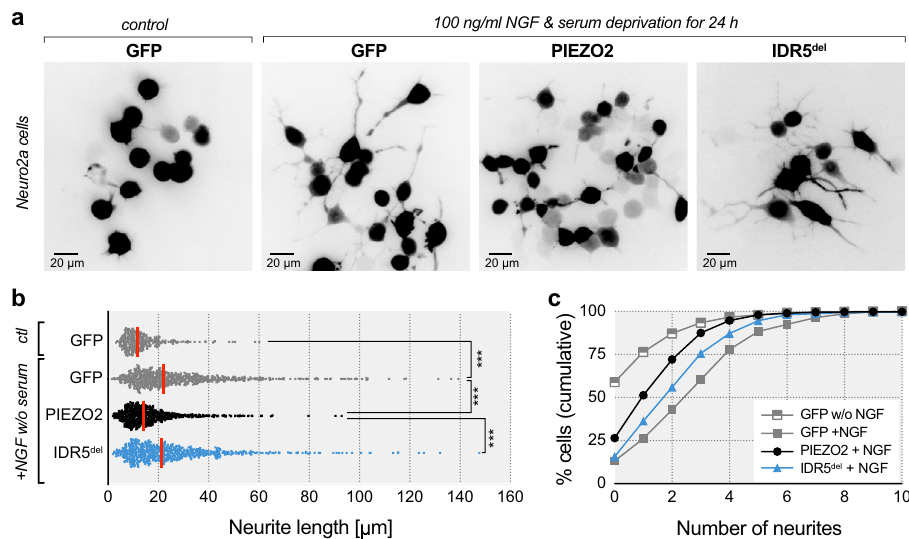
Fig. 6 PIEZO2 but not IDR5 del inhibits neurite outgrowth from N2a cells. a Representative inverted fl uorescent images of N2A-P1KO transfected with GFP vector in control medium (left), GFP, PIEZO2 (middle) or IDR5 del (right) in medium without serum and with nerve growth factor (NGF). b Representation of the longest neurite measured (in µ m) per cell for GFP in control medium and GFP (gray), PIEZO2 (black) and IDR5 del (blue) in medium without serum and with NGF. Comparison with Kruskal – Wallis test, p < 0.0001, and Dunn ’ s post-test: GFP control vs. GFP + NGF w/o serum ( P < 1e − 15), GFP + NGF w/o serum vs. PIEZO2 ( P < 1e − 15), PIEZO2 vs. IDR5 del ( P < 1e − 15). Symbols are individual cells, with red line being the median. N-number of cells per group is: GFP control ( N = 343), GFP ( N = 743), PIEZO2 ( N = 733), IDR5 del ( N = 685). c Cumulative distribution of the number of neurites per cell across GFP control, GFP, PIEZO2 and IDR5 del group. Total number of cells per group is: GFP control (N = 836), GFP ( N = 854), PIEZO2 ( N = 998), IDR5 del ( N = 810). Source data are provided as a Source Data fi